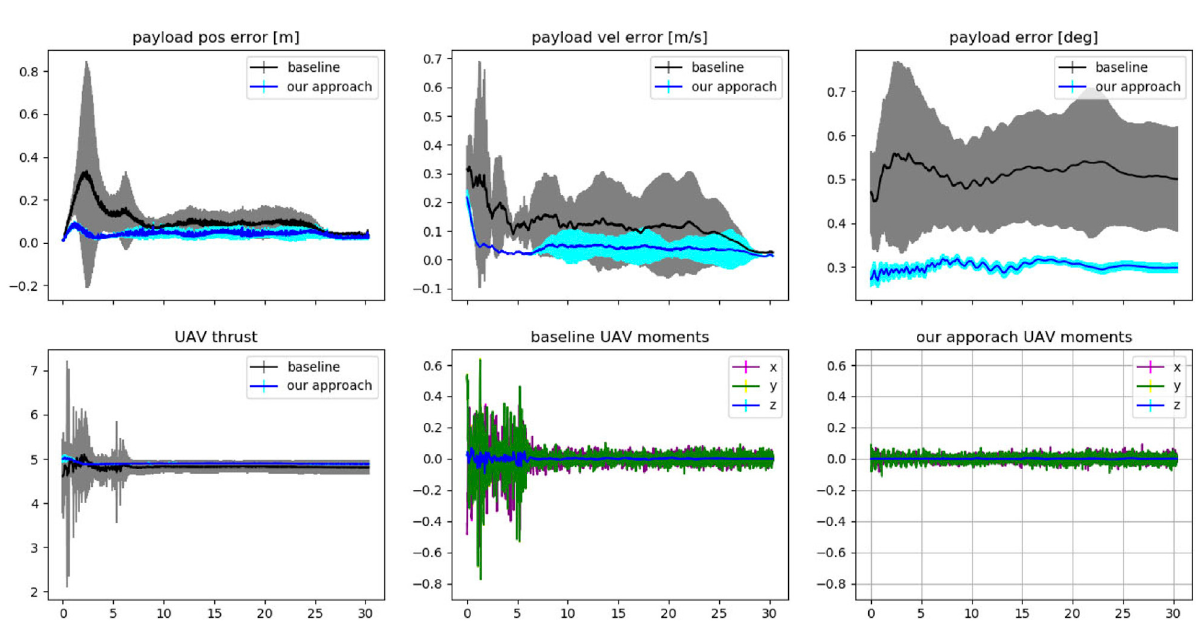
FIGURE 7 Theresultssummarise thetransportationexperiments.EachsolutionfromFigure6isusedfortentrialsinasimulatedenvironmentinwhichthe single or multiple UAVs lift thepayload, transportit along a circular trajectorytwice, and then hover thepayload above ground for at least 5 seconds. The x -axis represents the time in seconds for all plots. The top row shows the averaged position and velocity error w.r.t. the desired payload ’ s trajectory (baseline and proposed method separately), and both averaged rotational errors in the last plot. The bottom row shows the UAV ’ s thrust (together) and moments (separately). For the three UAVs condition, the values in the bottom row have been averaged for each